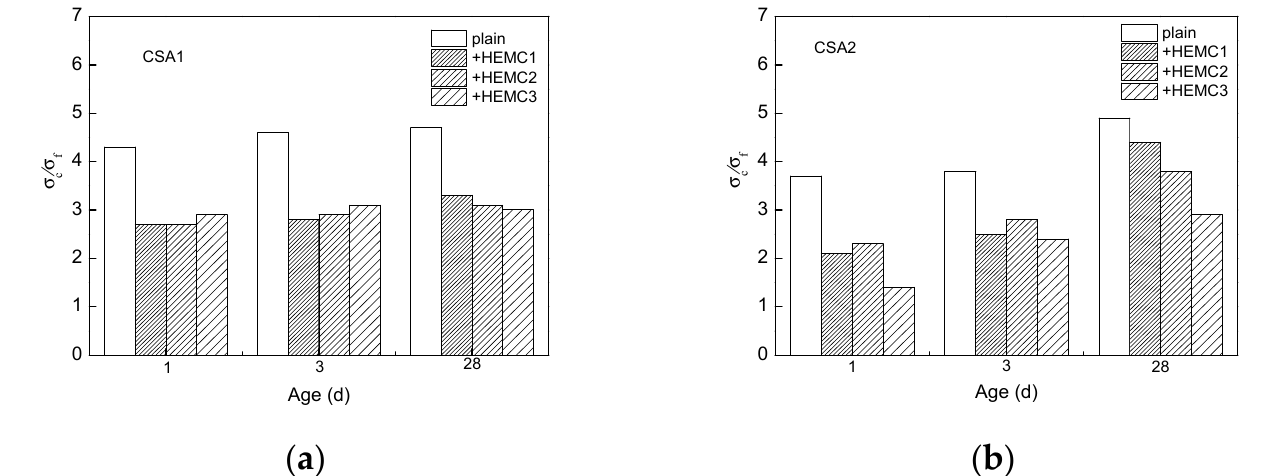
Figure 4. The ratio of compressive strength to flexural strength of CSA cement mortars with and without HEMCs at different curing ages: ( a ) CSA1, ( b ) CSA2.